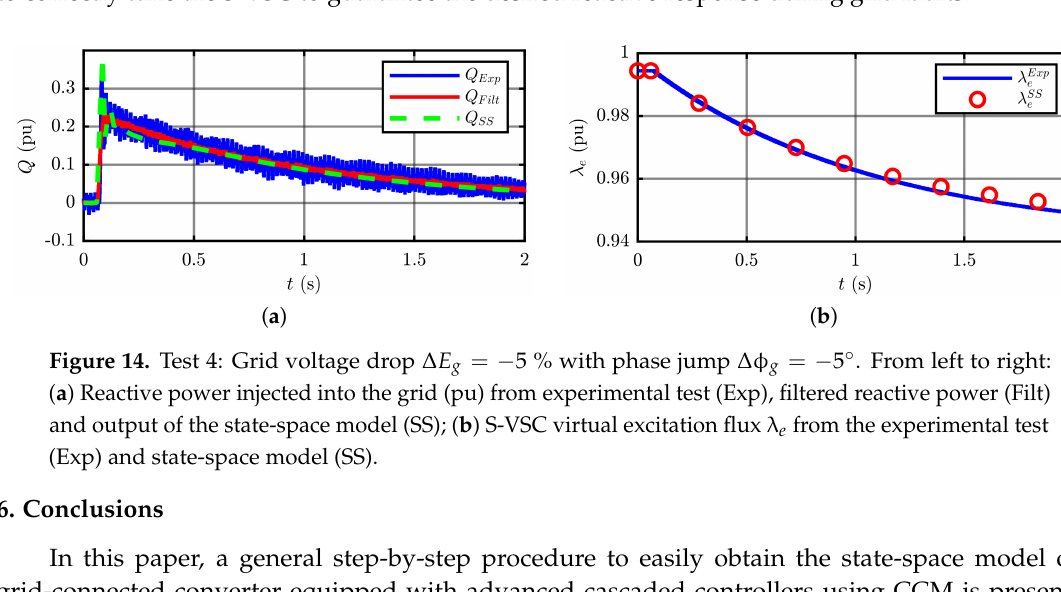
Figure 14. Test 4: Grid voltage drop ∆ E g = ( a ) Reactive power injected into the grid (pu) from experimental test (Exp), filtered reactive power (Filt) and output of the state-space model (SS); ( b ) S-VSC virtual excitation flux λ e from the experimental test (Exp) and state-space model